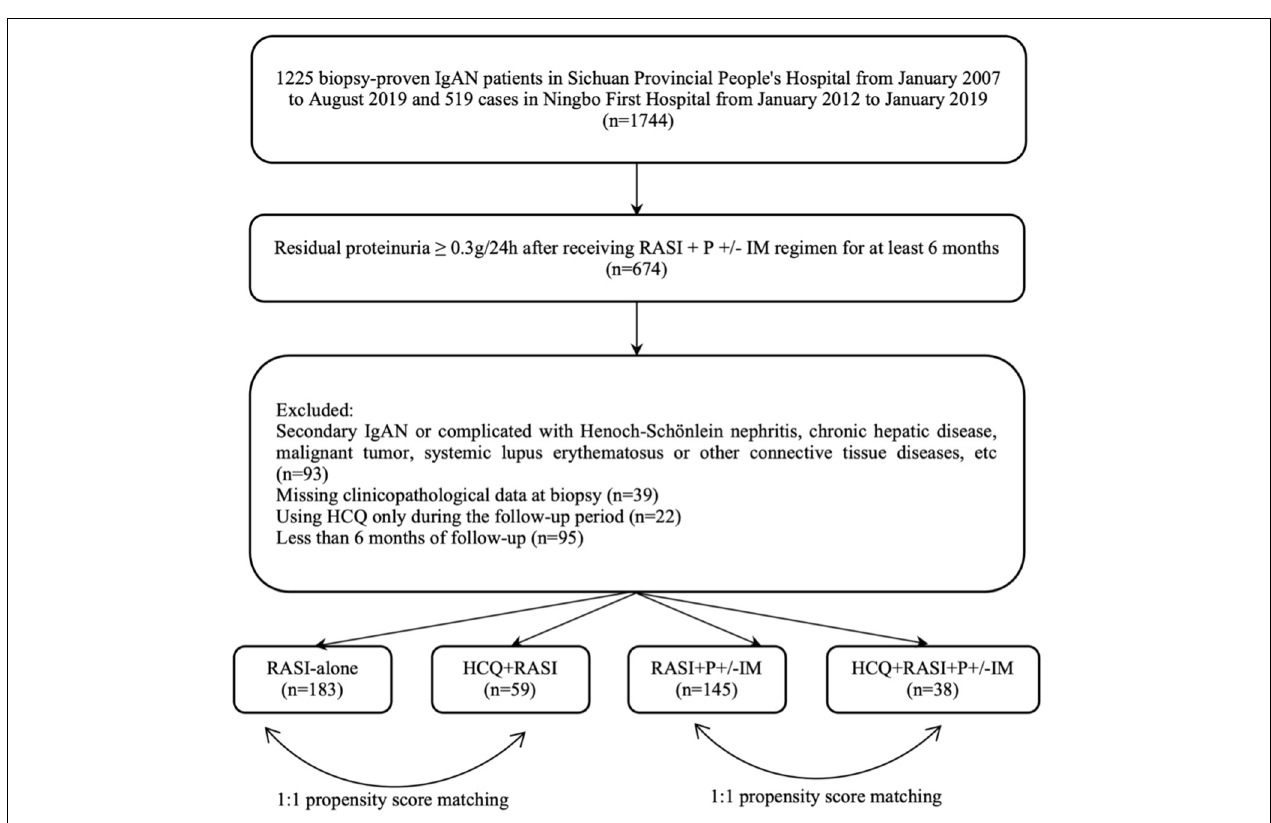
FIGURE 1 | Flow chart for screening IgAN patients with residual proteinuria after at least 6 months of traditional therapy.